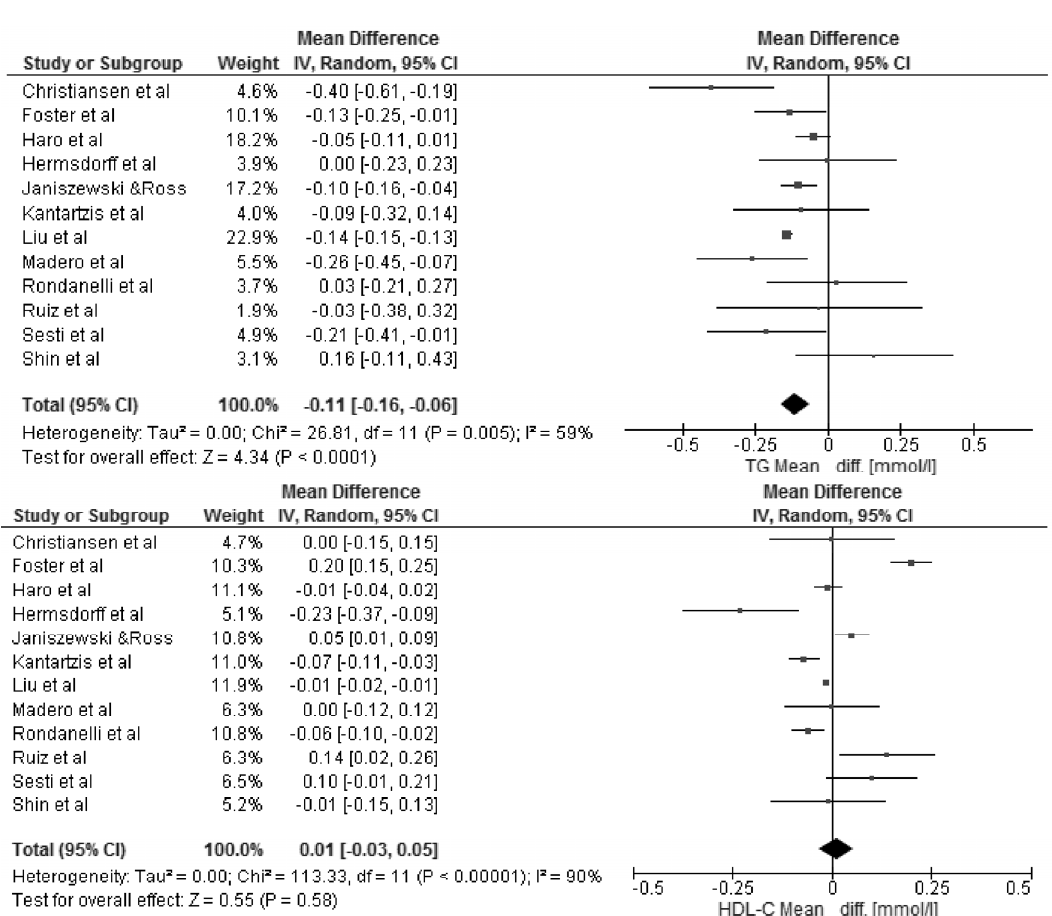
Figure 5. Forest plot of the random-effects meta-analysis of changes in Triglycerides and HDL-cholesterol according to reduction in energy intake shown as polled standard differences in the means with 95% Cis and in randomized and non-randomized trials. * For each study, the square represents the point estimate of the intervention effect. Horizontal lines join the lower and upper limits of the 95% CI of this effect. The area of shaded squares reflects the relative weight of the study in the meta-analysis. Diamonds represent the subgroup mean difference and pooled mean differences. CI indicates confidence interval.